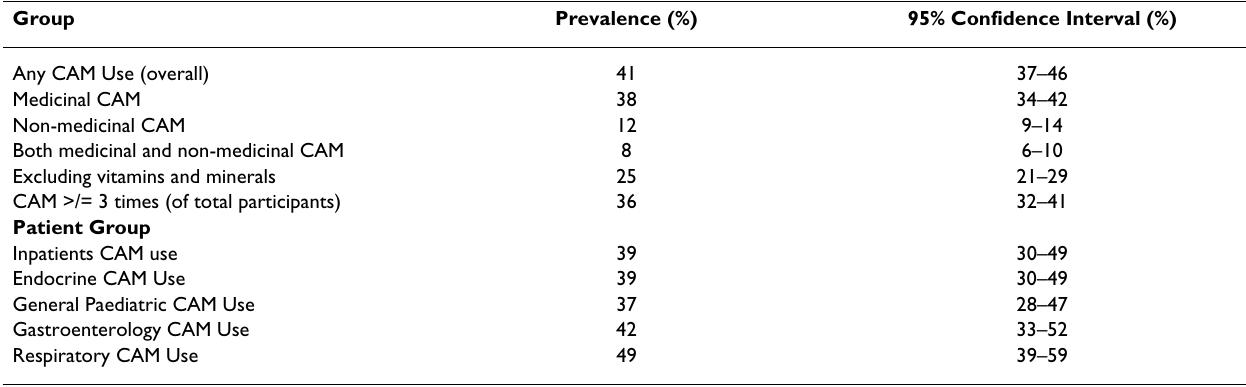
Table 1: 1-year Prevalence of Complementary and Alternative Medicine (CAM) Use